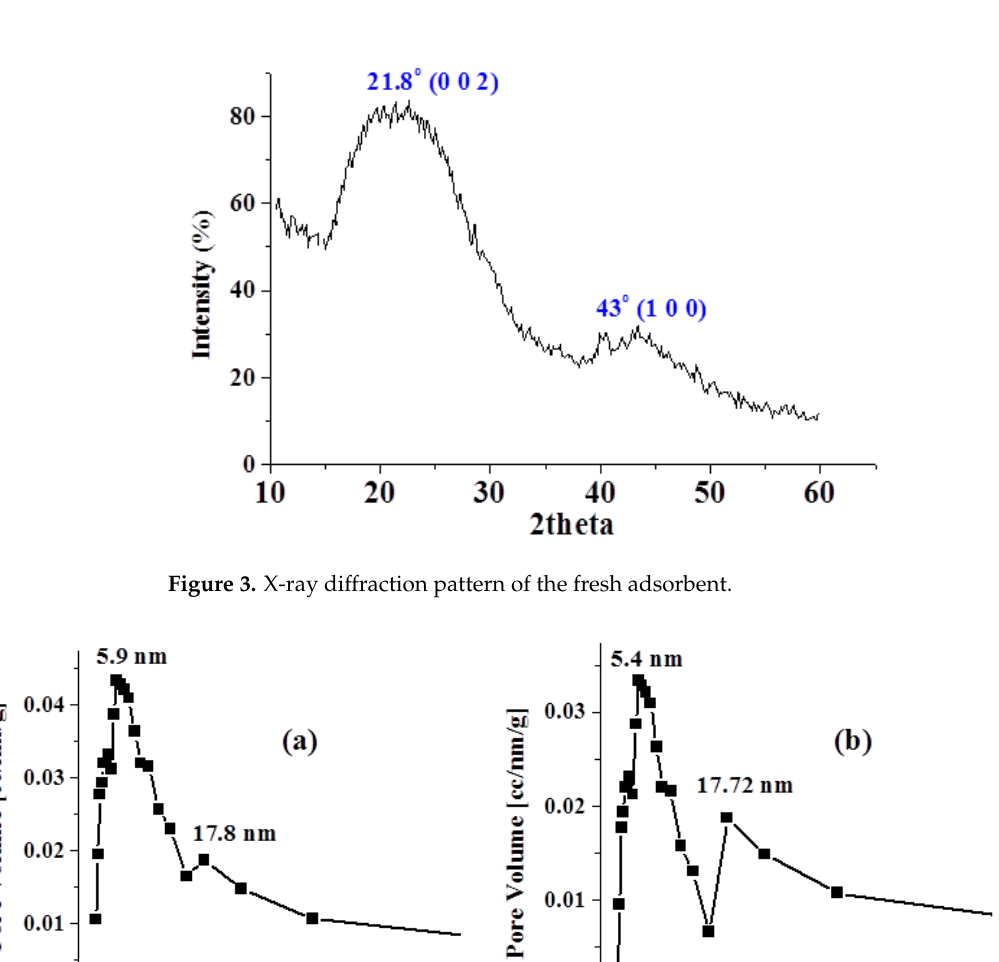
Figure 4. PSD curve of: ( a ) fresh adsorbent; ( b ) adsorbent.